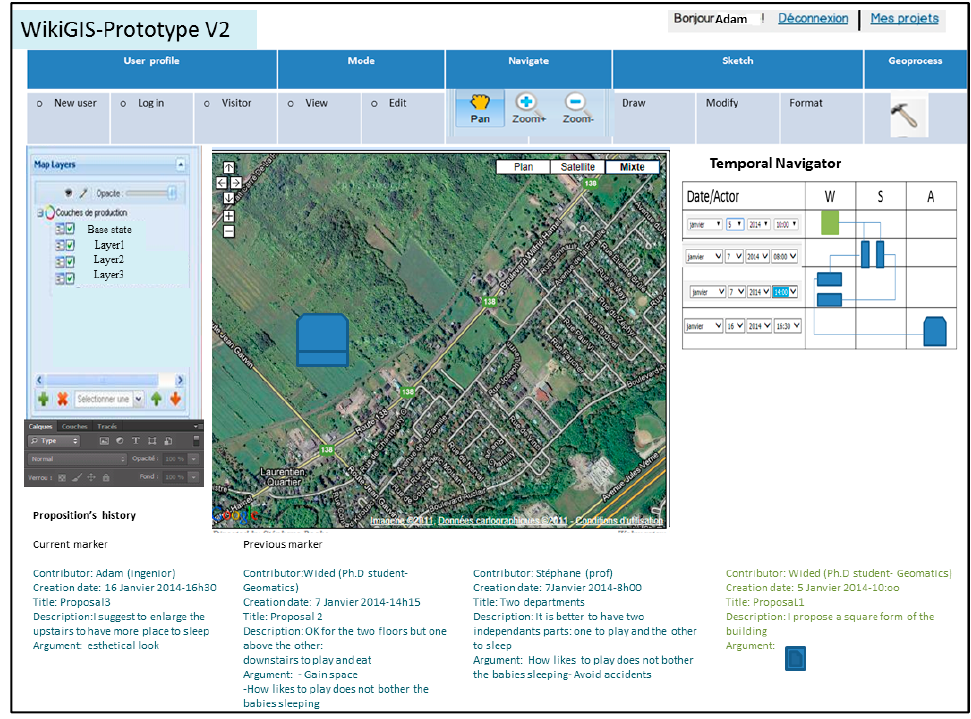
Figure 25. Fourth proposal in the project.